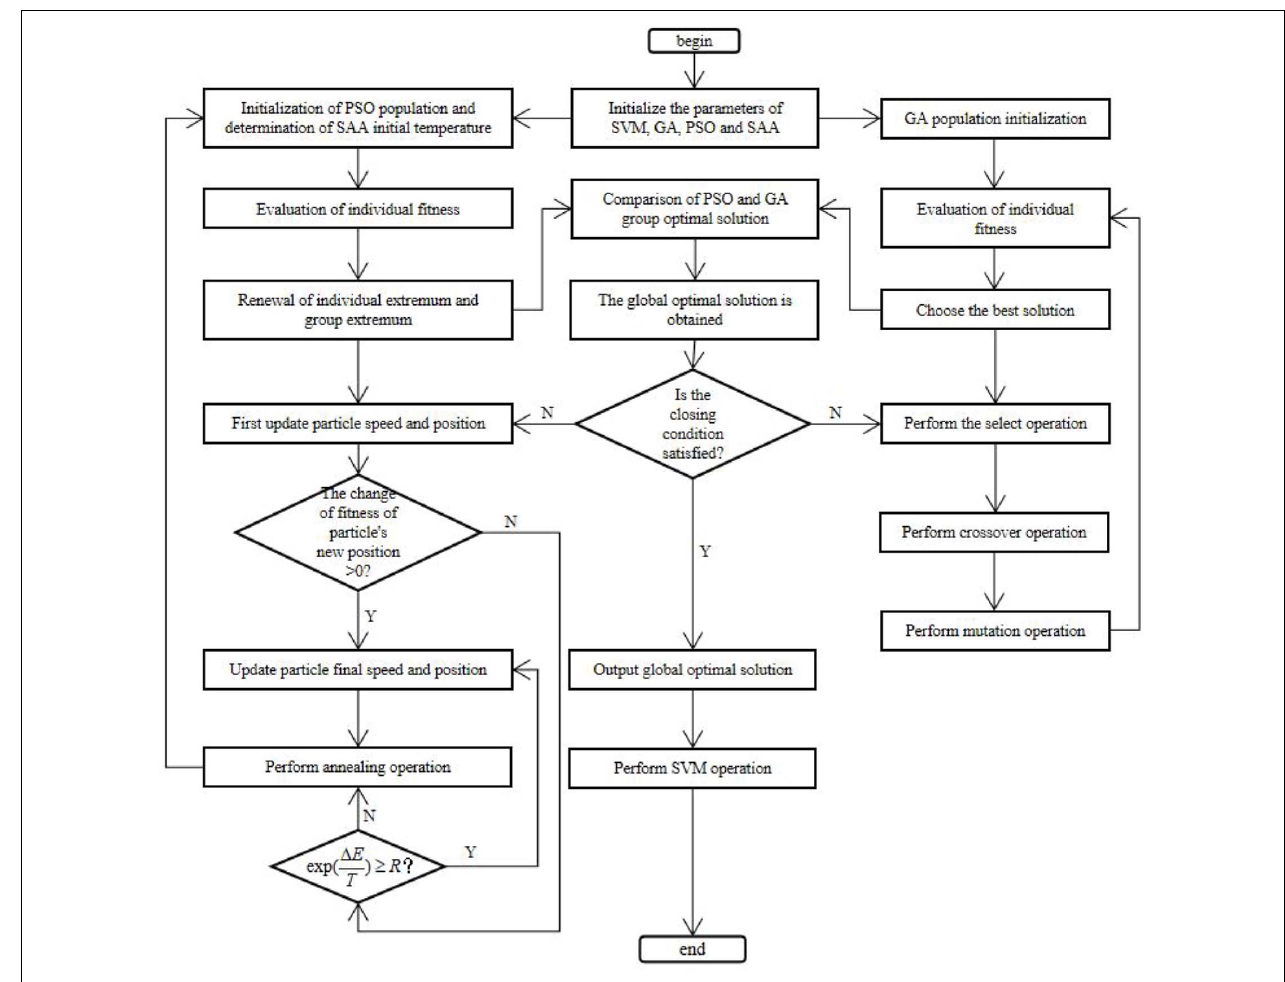
FIGURE 1 | Flow chart of GSP_SVM